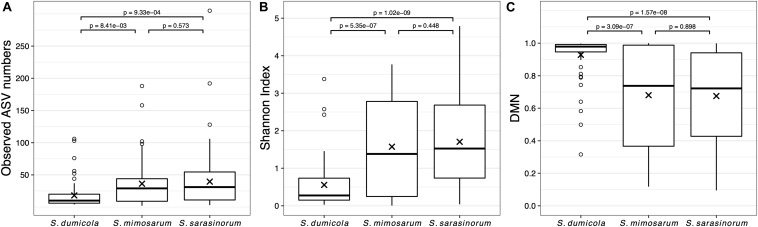
Microbiome richness, diversity, and dominance metrics for each of the three social Stegodyphus species based on subsampled data. Each data point is an individual spider. (A) Microbiome richness, represented by the number of observed ASVs. (B) Microbiome diversity represented by the Shannon index. (C) Microbiome dominance represented by McNaughton’s dominance (DMN) = sum of the relative abundances of the two most abundant ASVs in each sample. “x” indicates the means, p-values are based on pair-wise t-tests with Benjamini–Hochberg adjustment for multiple comparisons. n = 58 (S. dumicola), n = 60 (S. mimosarum), n = 98 (S. sarasinorum).